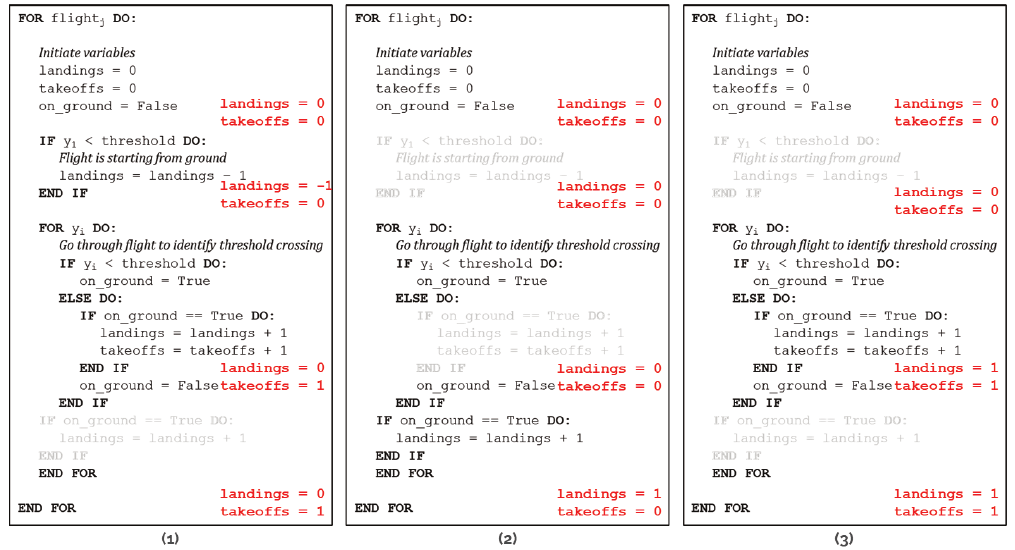
Figure 4 . Th e pseudocode for the landing/takeoff detection indicates how the algorithm adjusts the landings and takeoff s counters accordingly for each of the three cases depicted in Figure 3. In Case (1), the algorithm will eventually detect a takeoff . However, since the fl ight starts on the ground, we start the landings counter at –1 to prevent the extra lading from the initial altitude being below the threshold. Case (2) is more straight-forward, with the aircraft being above the specifi ed altitude threshold until landing. Th e algorithm ignores the if statement counting touch and goes, in black. In Case (3) the aircraft starts airborne but the fl ight track does not end with the landing, making that portion of the fl ight a touch and